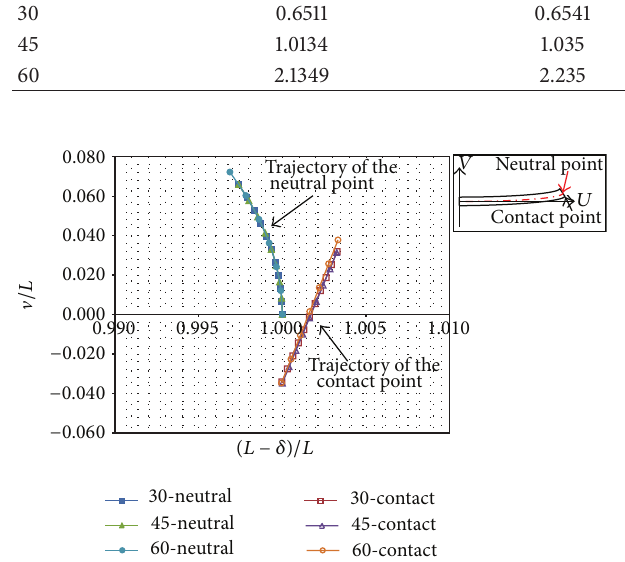
Figure 10: Dimensionless positions of neutral point and contact point.